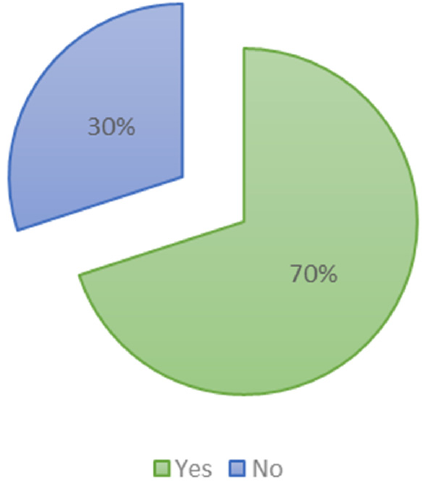
Figure 6. Impact that wood waste can have on the environment.